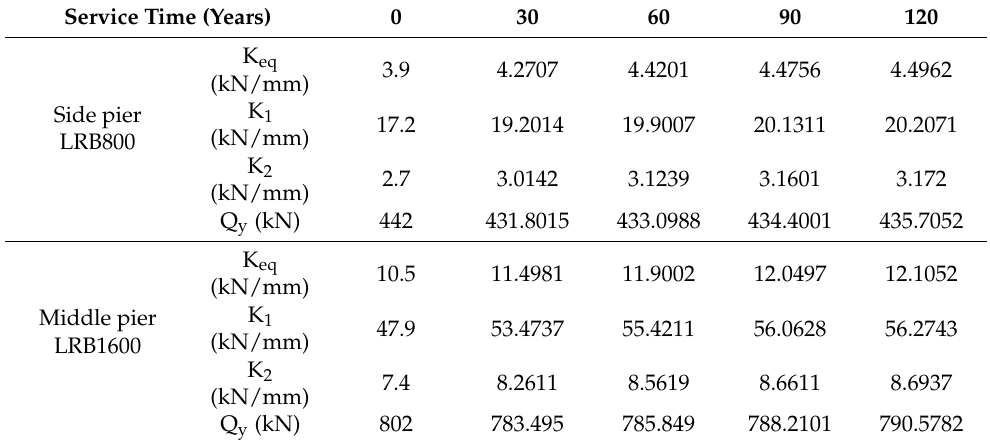
Table 8. LRB time-varying parameters.